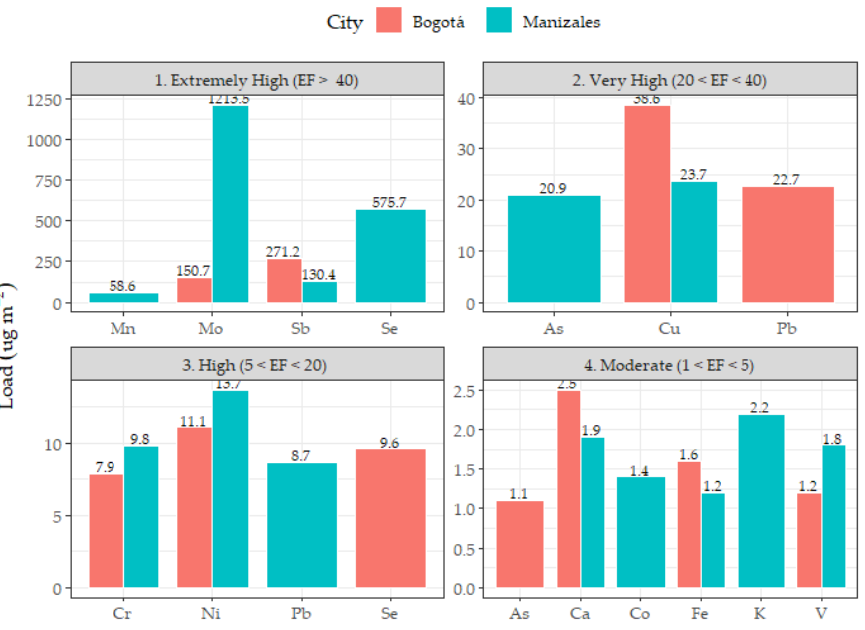
Figure 10. Enrichment factors in Bogotá and Manizales.